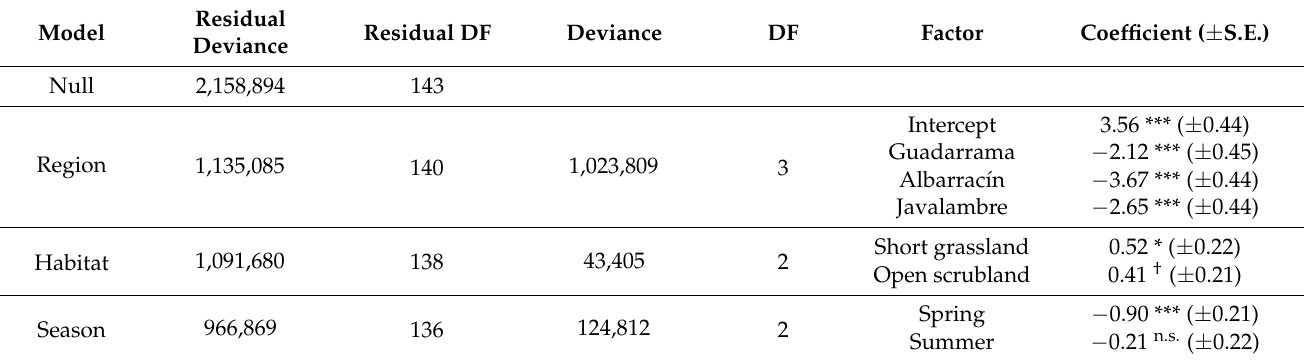
Table 2. Generalized linear model for the proportion of analogous monthly maximum tempera- tures between 1980-89 and 2010-19 for modelled microclimate in three reference habitat types: H1 (pine forest), H7 (open scrubland), H10 (short grassland). Reference categories are Region—Gredos; Habitat—H1—pine forest; Season—Autumn/Winter. The best model was selected based on a quasib- inomial error term using quasi Akaike information criterion (QAIC). QAIC of null model = 281.55, QAIC of model shown = 142.39, QAIC of next-best model =